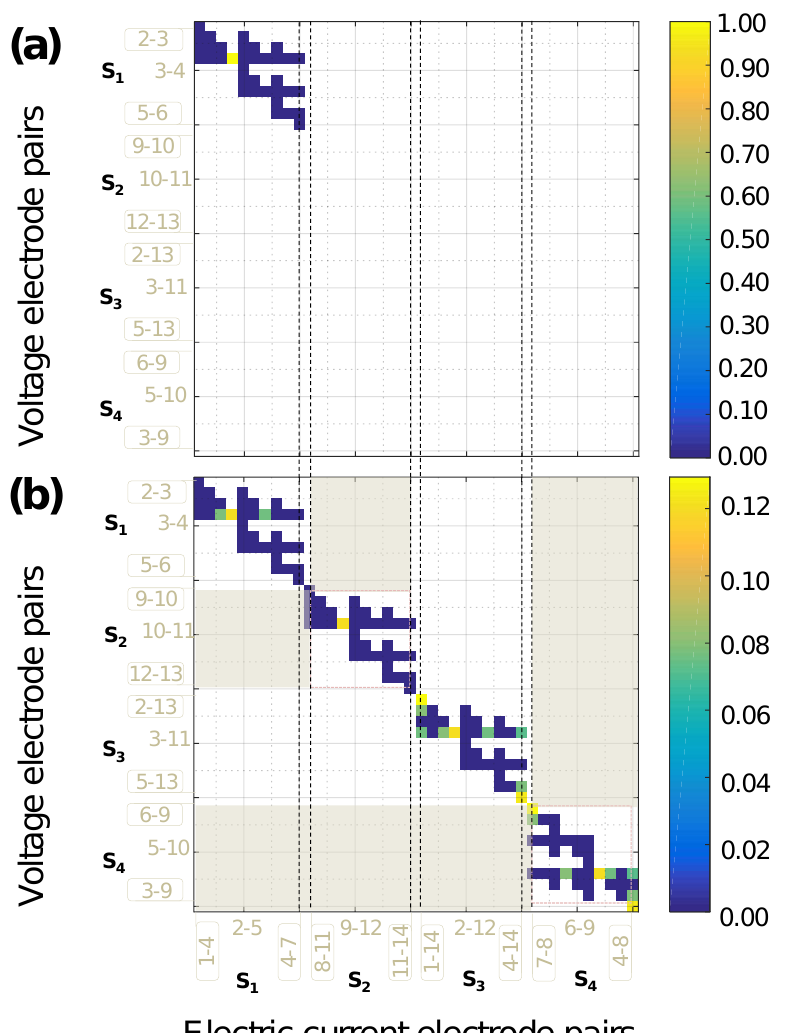
Figure 7. Results of Effective Independence on four-probe schemes on [ 0 4 /90 4 ] s layup using ( a ) one-sided electrodes and ( b ) two-sided electrodes. Column sections show groups for surface resistance ( S 1 , S 2 ) and oblique resistance ( S 3 , S 4 ) measurements. Cells in dark blue indicate eliminated combination with low EI